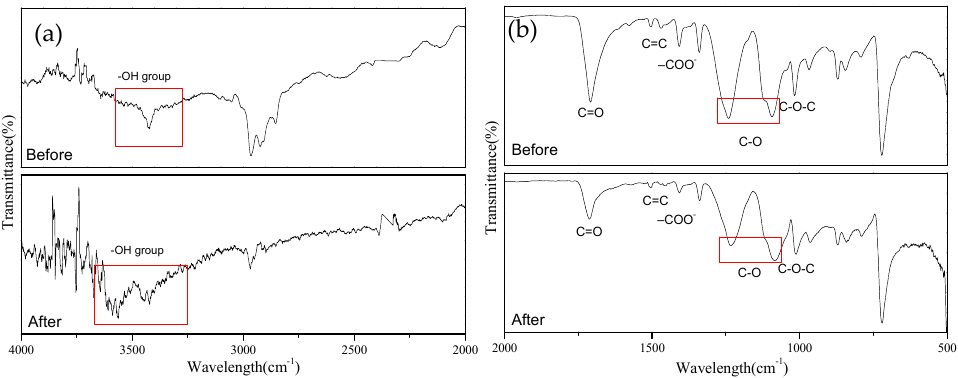
Figure 12. FTIR images of PET before and after surface modification: ( a ) 2000–4000 cm − 1 ; ( b ) 500–2000 cm − 1 .